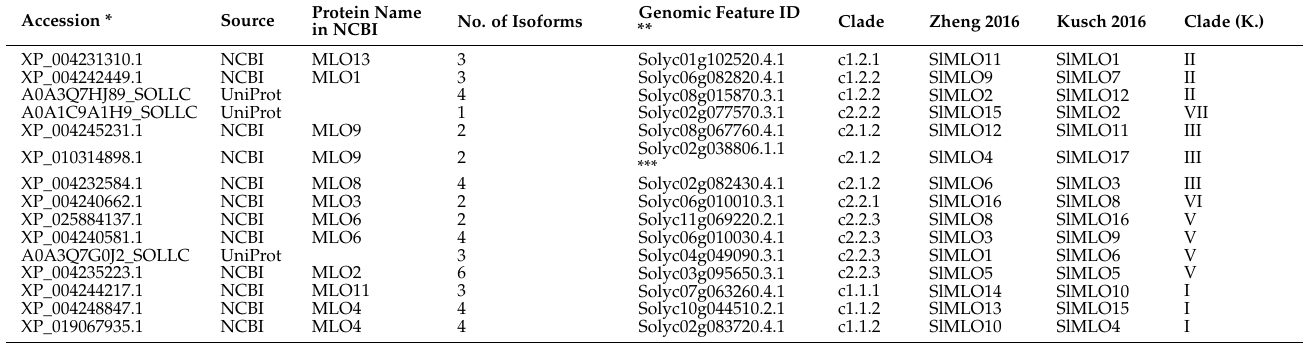
Table 5. The tomato MLO